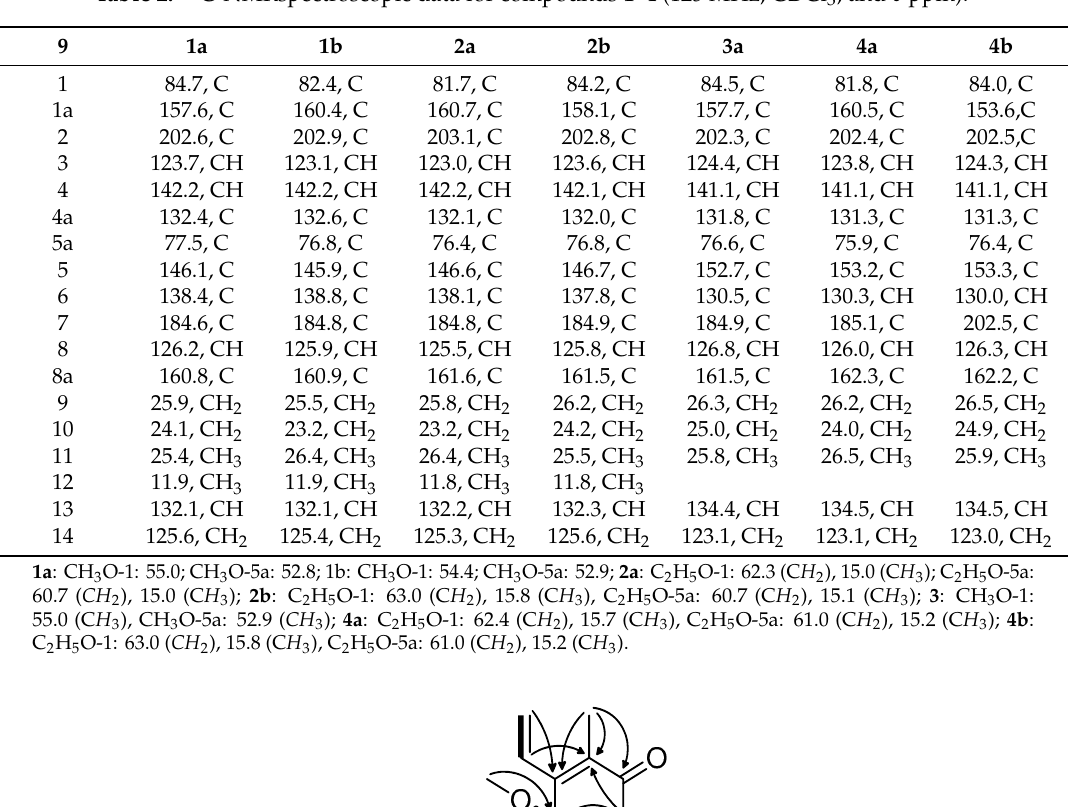
Table 2. 13 C-NMRspectroscopic data for compounds 1 – 4 (125 MHz, CDCl 3 , and δ ppm).